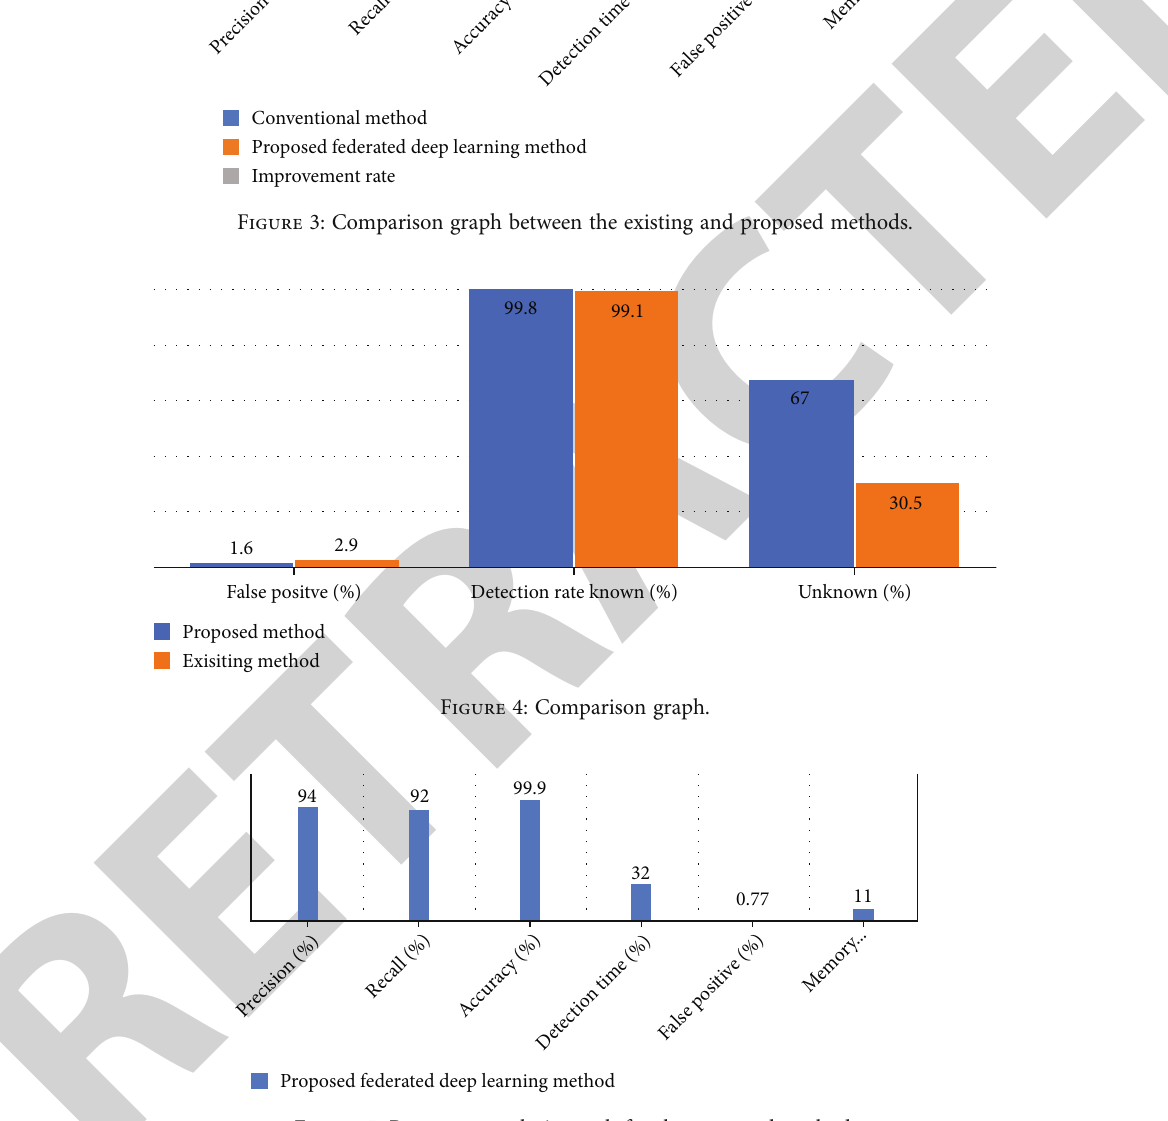
Figure 5: Parameter analysis graph for the proposed